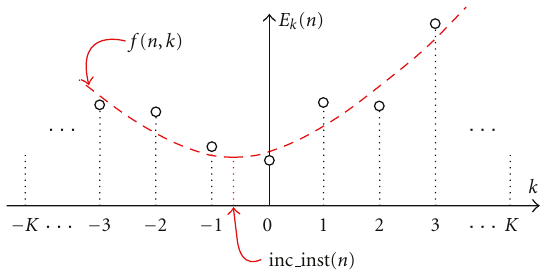
Figure 5: Least-squares curve